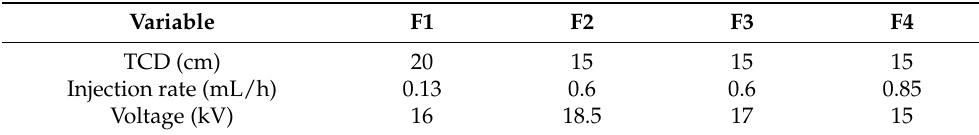
Table 3. Experimental conditions for the electrospinning procedure of the nanocomposites